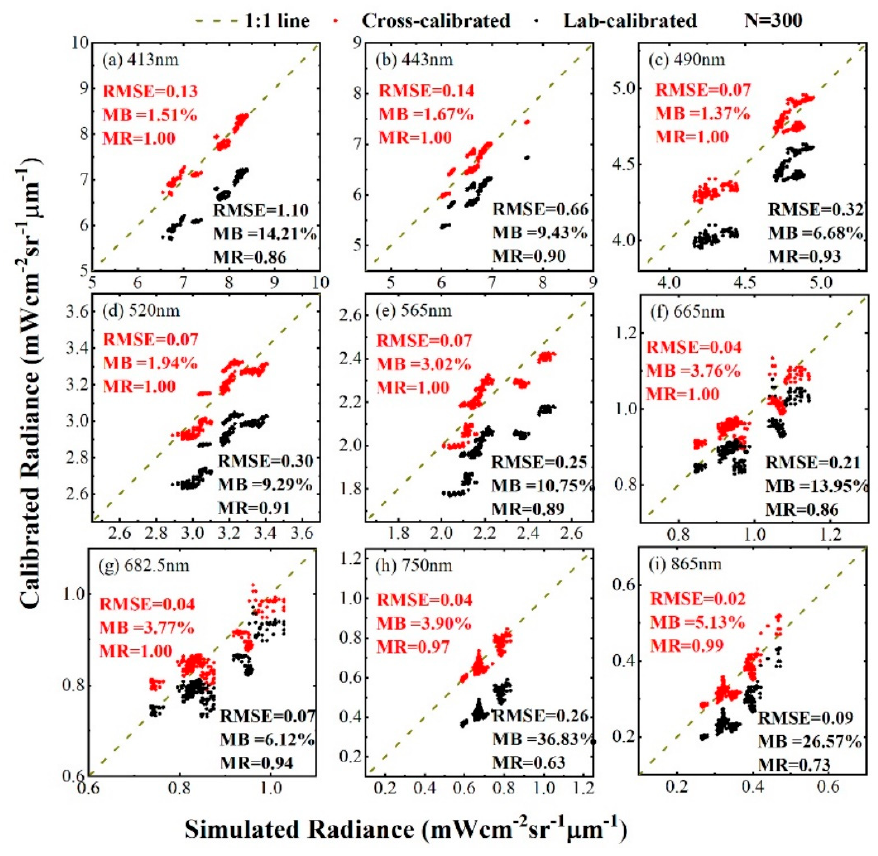
Figure 5 . Evaluation of calibrated TOA radiance of MWI using simulated TOA radiance from concurrent MODIS images. RMSE, MB and MR are root mean square errors, mean bias and mean ratio, respectively.